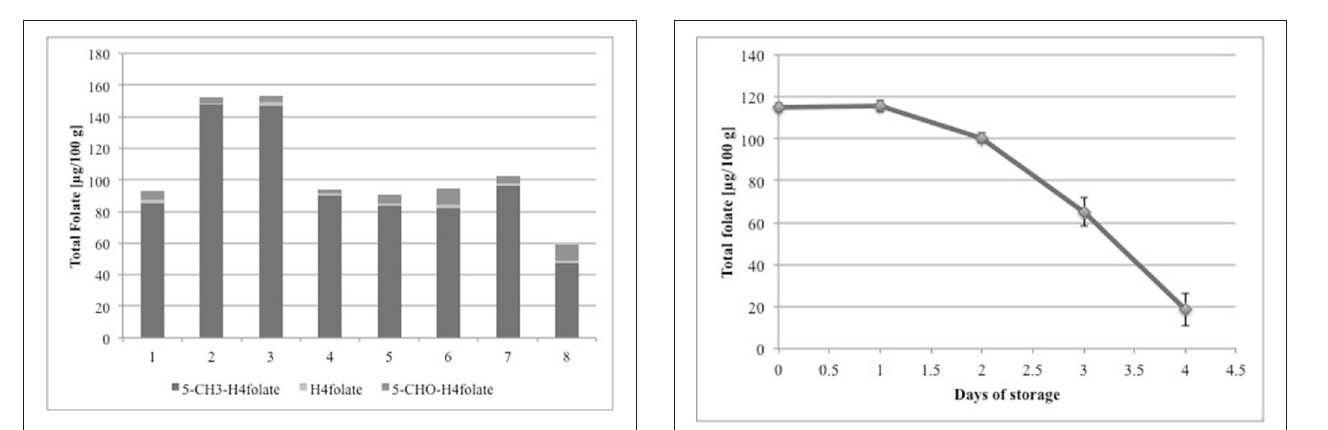
FIGURE 4 | Folate retention during storage of fresh, blended strawberries of a commercial cultivar at 7 ◦ C in the dark. Total folate concentrations are calculated as PteGlu in [ µ